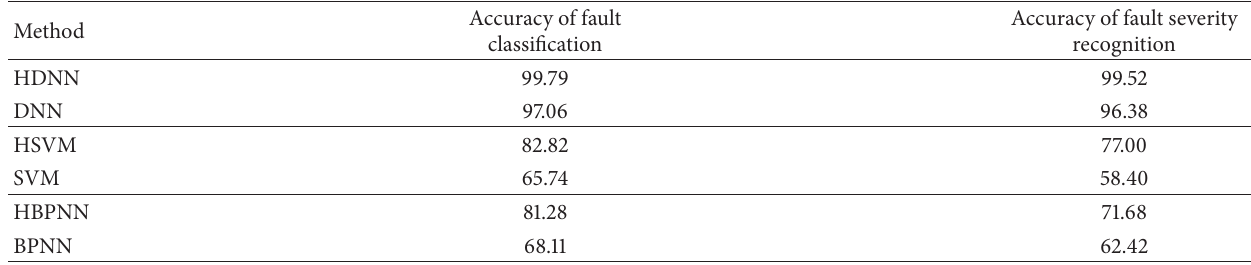
Table 5: Fault severity classification result comparison after mode partition.